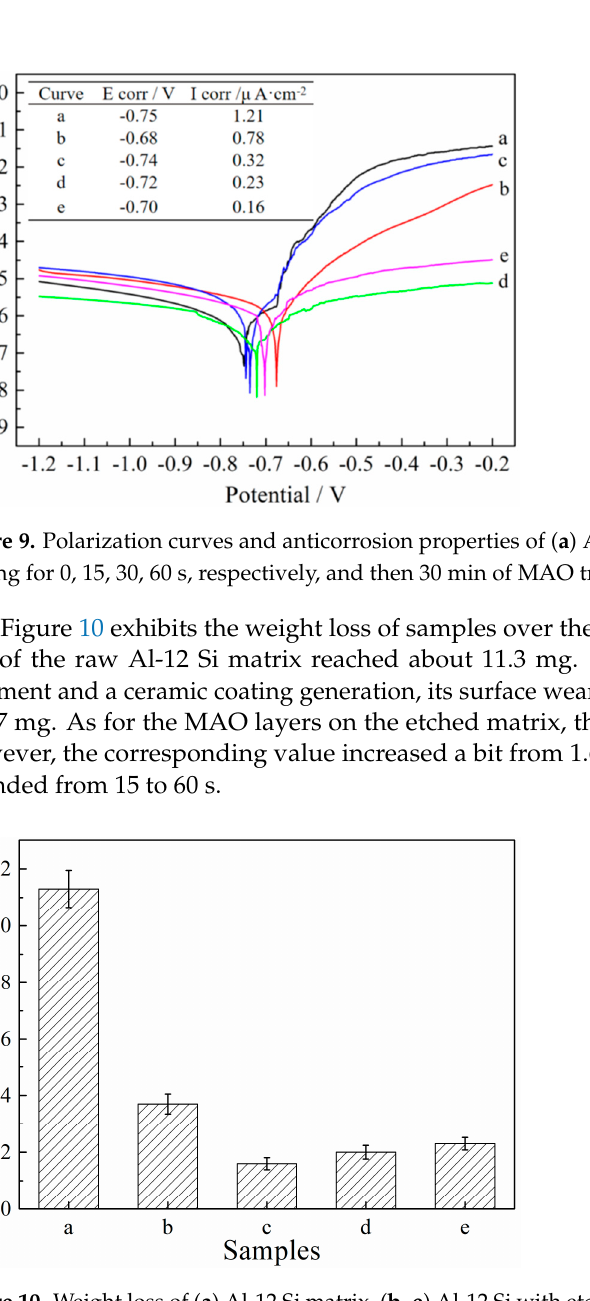
Figure 10. Weight loss of ( a ) Al-12 Si matrix, ( b – e ) Al-12 Si with etching for 0, 15, 30, 60 s, respec- tively, and then 30 min of MAO treatment.